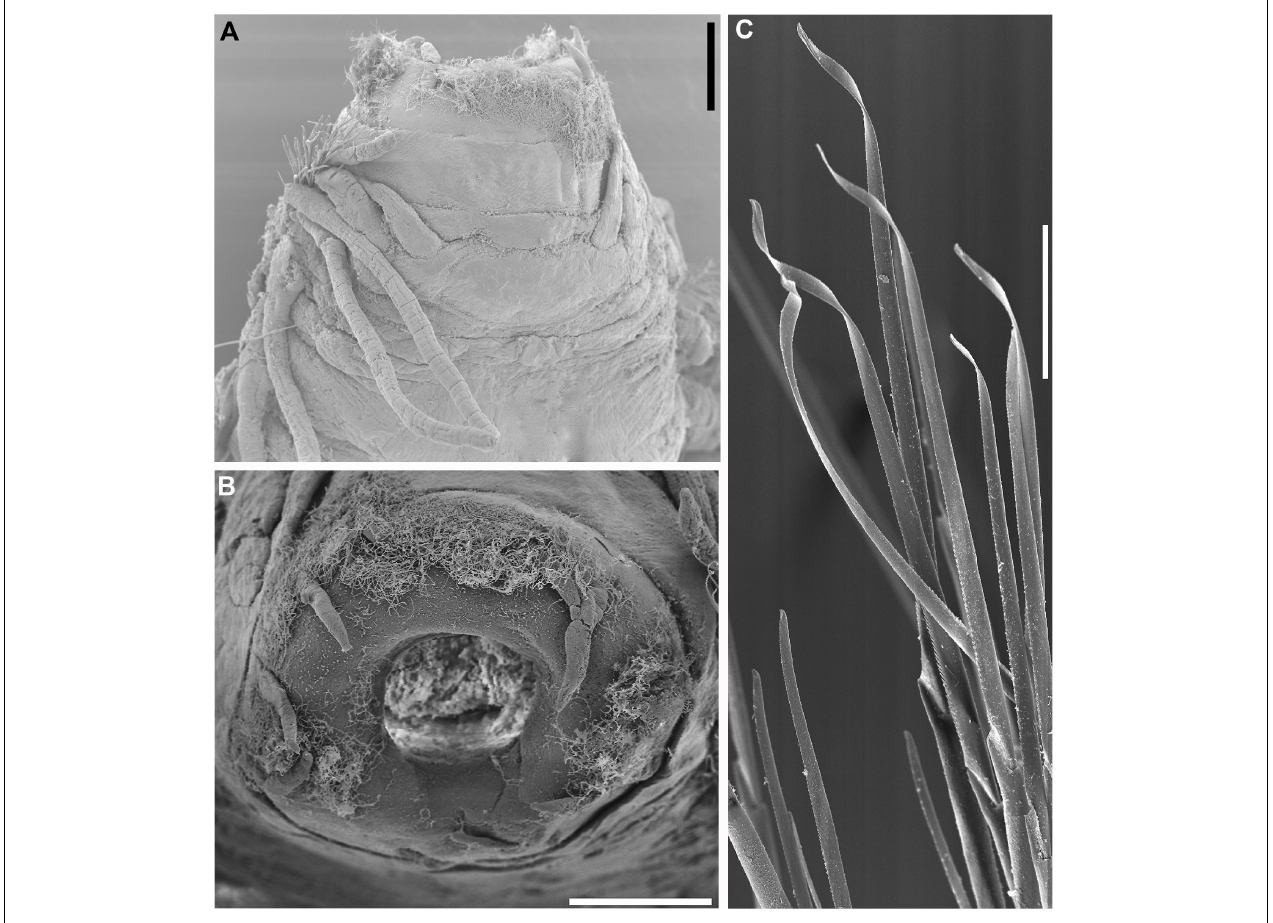
FIGURE 13 | Sirsoe besnard sp. nov. (A) anterior end, dorsal view; (B) detail of proboscis; (C) neurochaetae from median neuropodia. (A,B) 200 µ m; (C) 50 µ